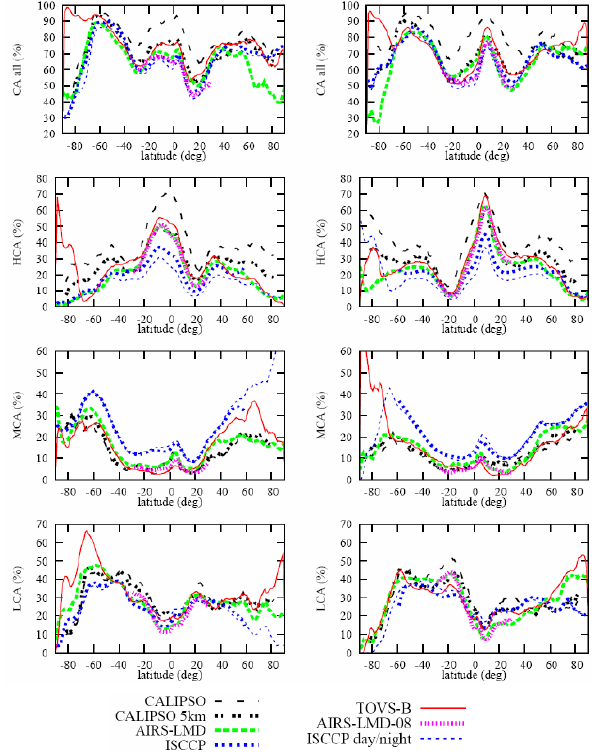
Figure 7: Zonal averages of total, high, midlevel and low-level cloud amount from AIRS-LMD compared to results from various cloud climatologies, in January (left) and in July (right).